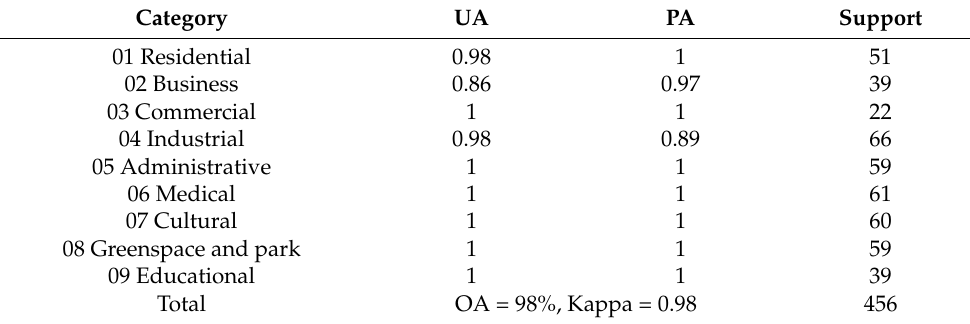
Figure 5. Maps of AOI data. ( a ) The map of AOI data; ( b ) a zoomed-in view of ( a ). Table 3. Summary of AOI classification results. UA, PA, and Support donate user’s accuracy, producer’s accuracy, and the number of validation